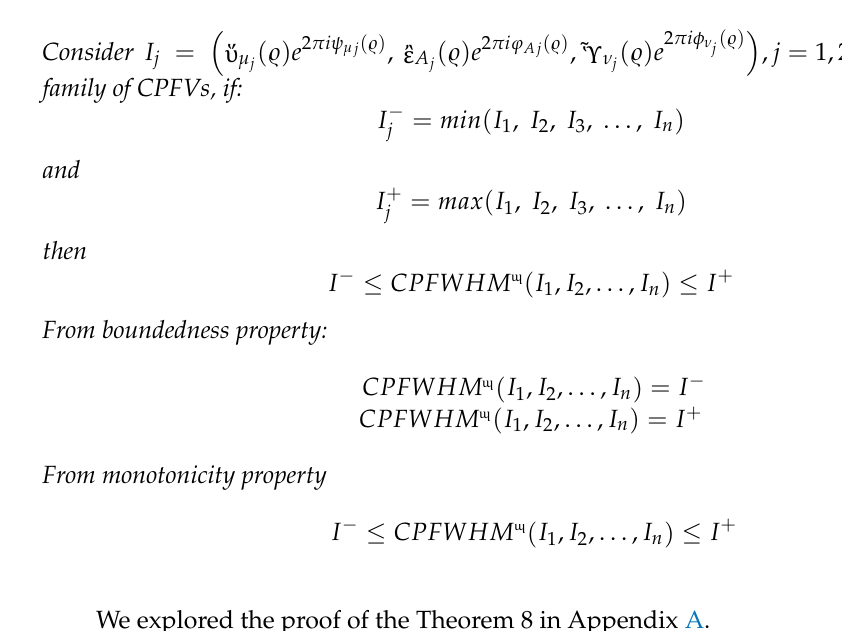
Table 1. Symbols and their meanings.